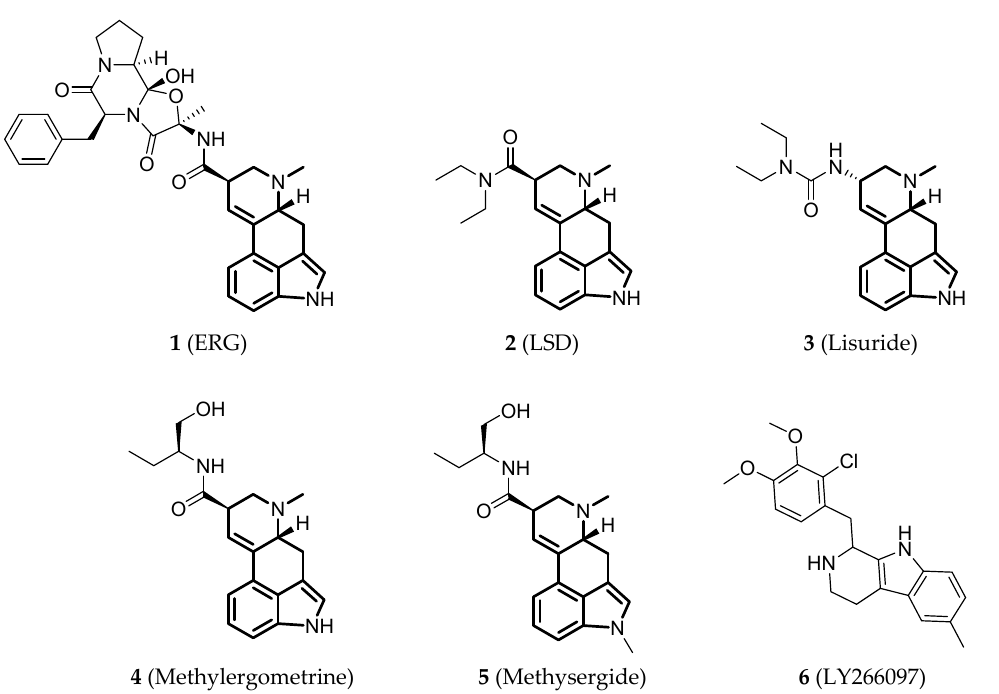
Figure 1. Small-molecule ligands in co-crystal structures of 5-HT 2B R-ligand complexes.